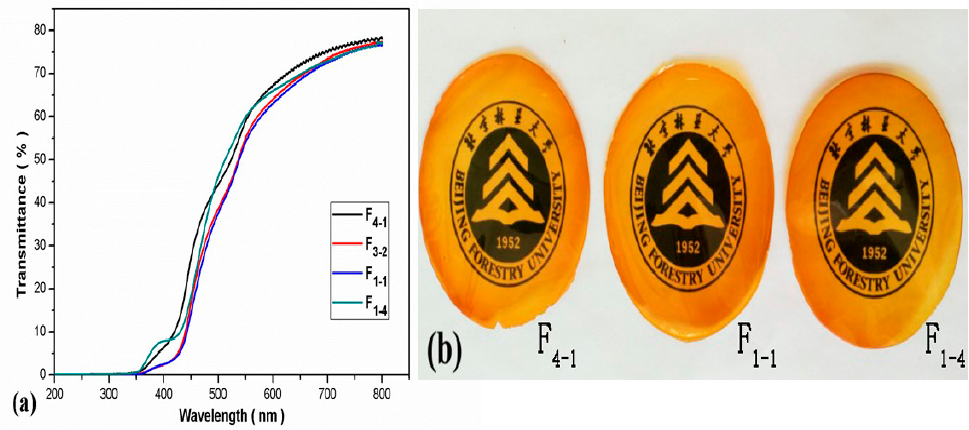
Figure 5. ( a ) UV-Vis transmittance of composite films (F 4-1 , F 3-2 , F 1-1 , F 1-4 ); ( b ) Photograph of composite films (F 4-1 , F 1-1 , F 1-4 ).